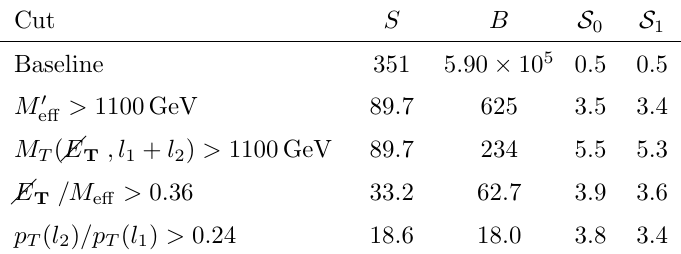
= 500 GeV and m = 1 TeV. We 2 ; 3 (cid:6)